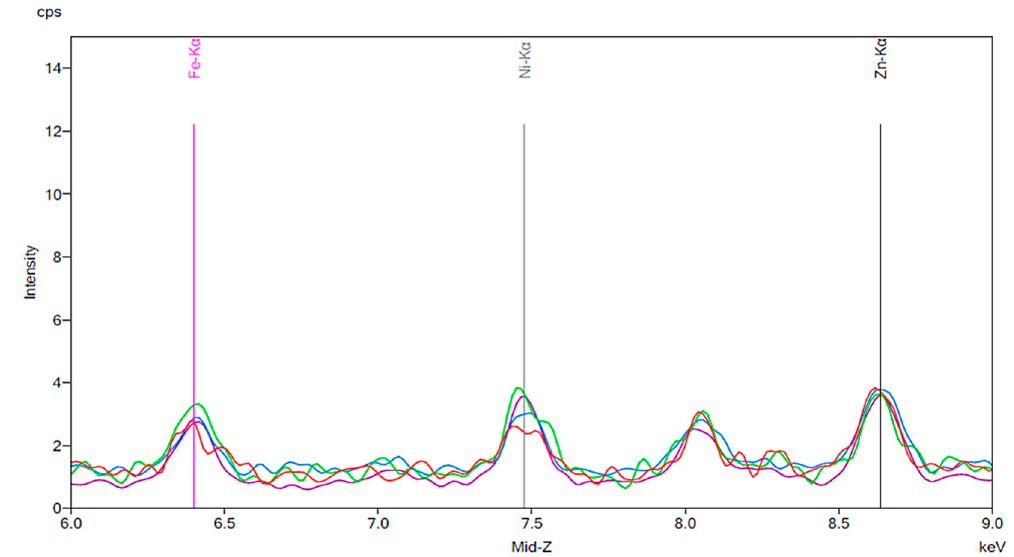
Figure 9. The results of an experiment in which new artificial teeth and artificial teeth after wear were exposed to tea. The red peaks and the green peaks correspond to the new artificial tooth with no wear before and after exposure to tea for 24 h, respectively. The blue and purple peaks represent the worn-down artificial tooth before and after 24 h of exposure to tea, respectively.